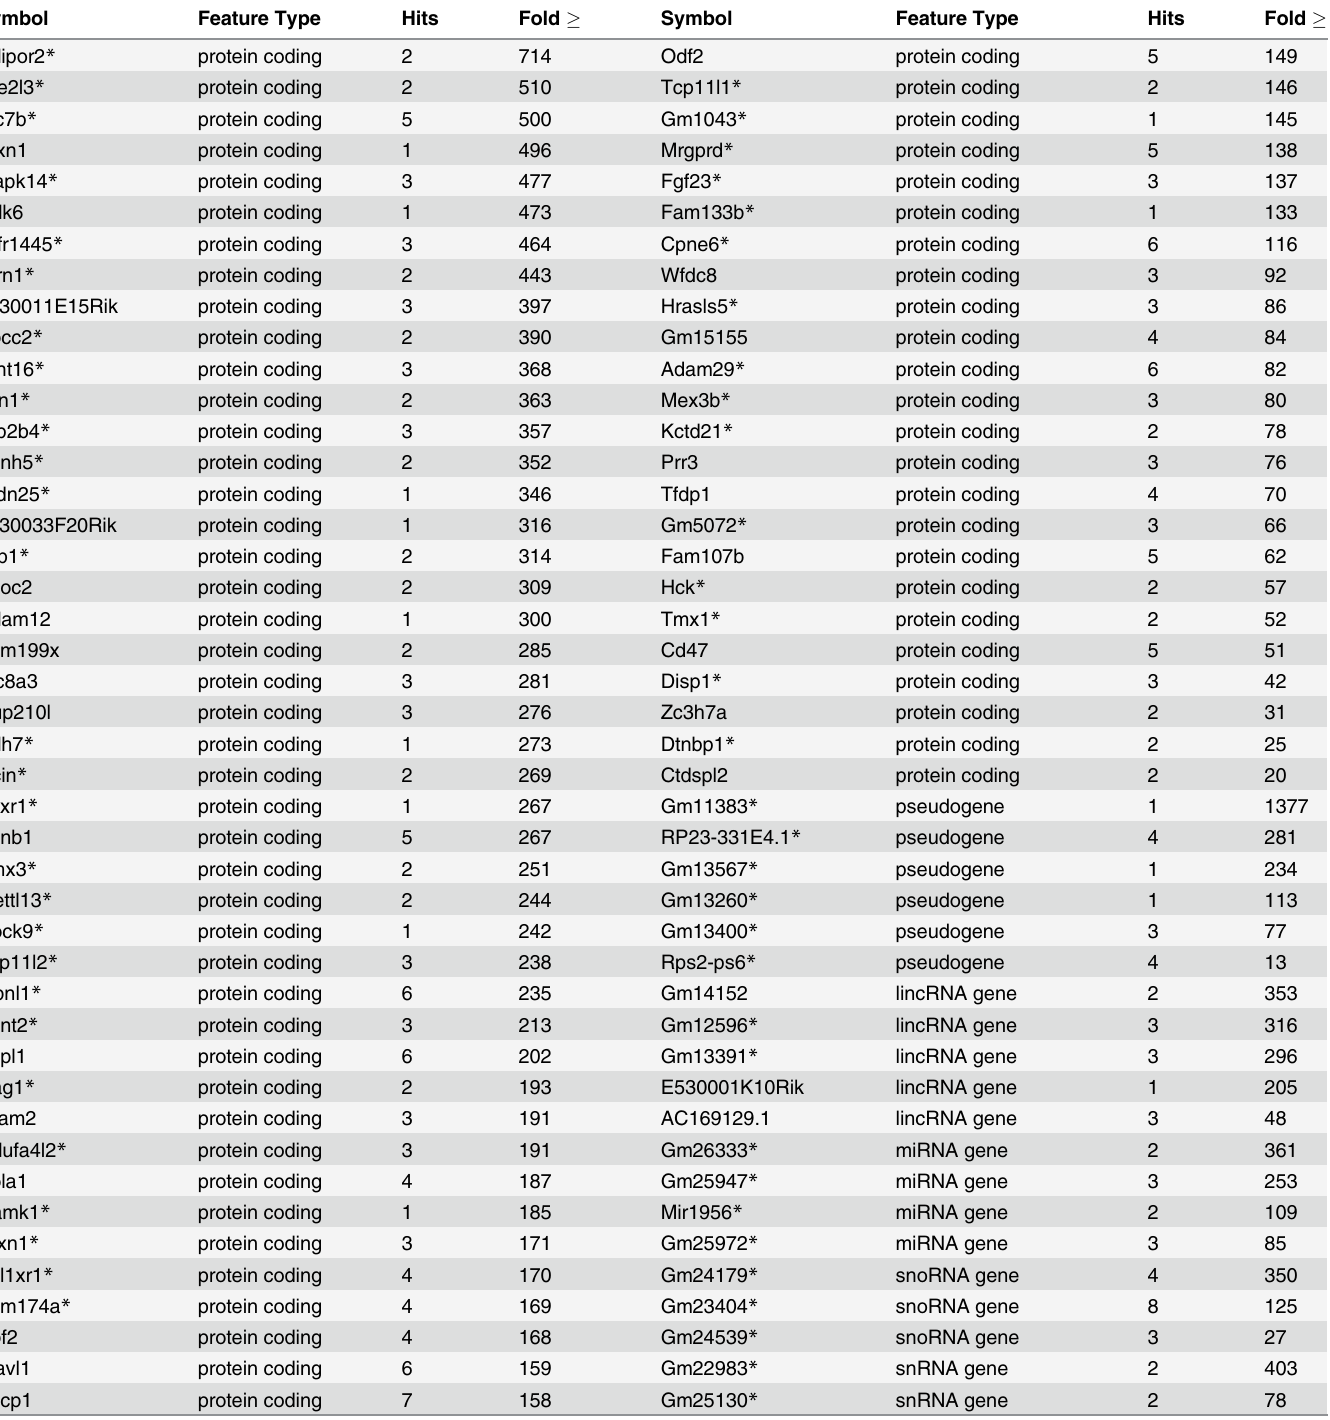
Table 2. Top 100 significant RIP-Seq regions arranged by gene type. The top 100 significantly different annotated regions from among 271 identified via RIP-Seq are given along with the total number of significant ‘ hits ’ (binding events) at that region among two independent RIP experiments. Fold denotes the minimum fold change observed across all of the hits, where fold change is expressed as (HuR/IgG). All regions given in this table have a minimum q-value (false discovery rate value based on method of Benjamini-Hochberg) < 1E-99 from testing for HuR binding to RNA. The regions are arranged by gene type, and then sorted by fold change. Location of binding overlaps the annotated region unless otherwise